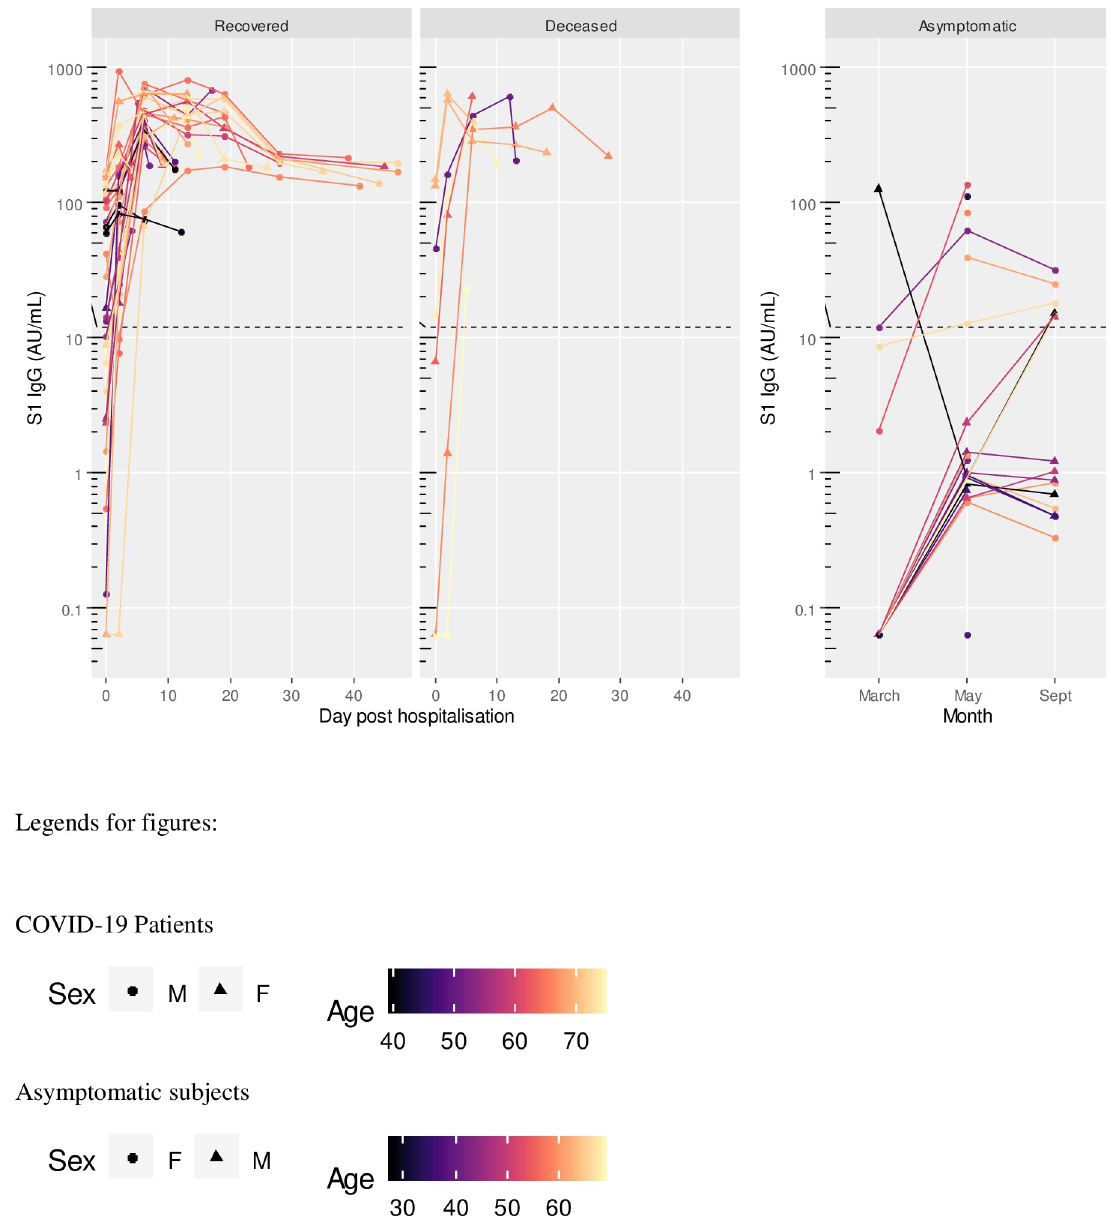
Fig 3. S1 IgG titres in COVID-19 patients (recovered and deceased) and asymptomatic subjects. Black dashed line indicates positivity threshold at 12